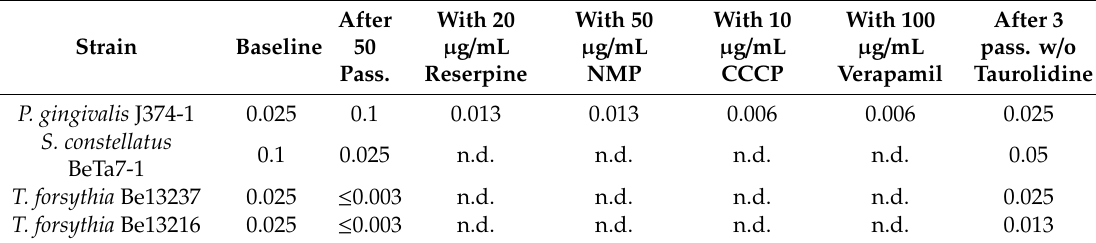
Table1. MICoftaurolidine(% w / v )ofstrainswithchangedMICvaluesafter50passagesonsubinhibitory concentrations of taurolidine. Presented are MIC values before and after 50 passages, after addition of e ffl ux inhibitors reserpine, NMP, CCCP, verapamil (only strain showing increase of MIC) as well as after additional three passages on agar plates free of antimicrobials.